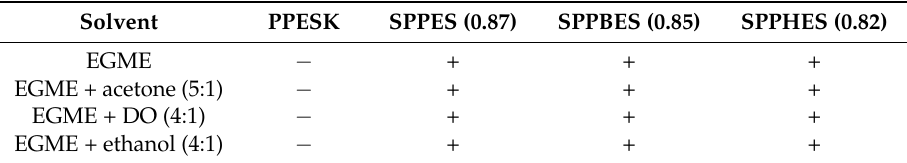
Table 3. Solubility of PPESK and sulfonated poly(aryl ether sulfone)s.